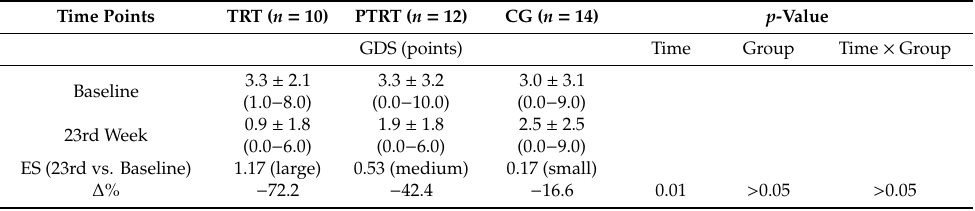
Table 3. Prevalence of depressive symptoms at baseline and after 5, 14 and 23 weeks according to group allocation.